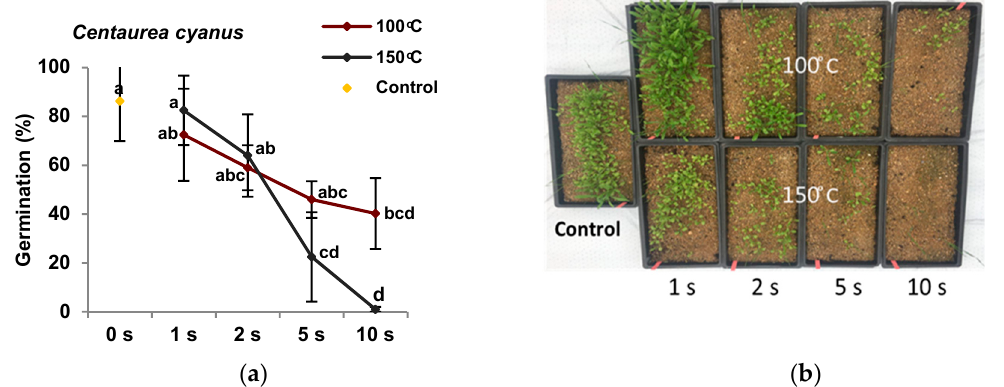
Figure 7. ( a ) Average germination percentage of Centaurea cyanus (N = 4) after the chaff with seeds has been exposed to a temperature of 100 °C or 150 °C for 1, 2, 5, and 10 s. Bars show standard deviation. ( b ) Example of a replicate ordered after treatments.